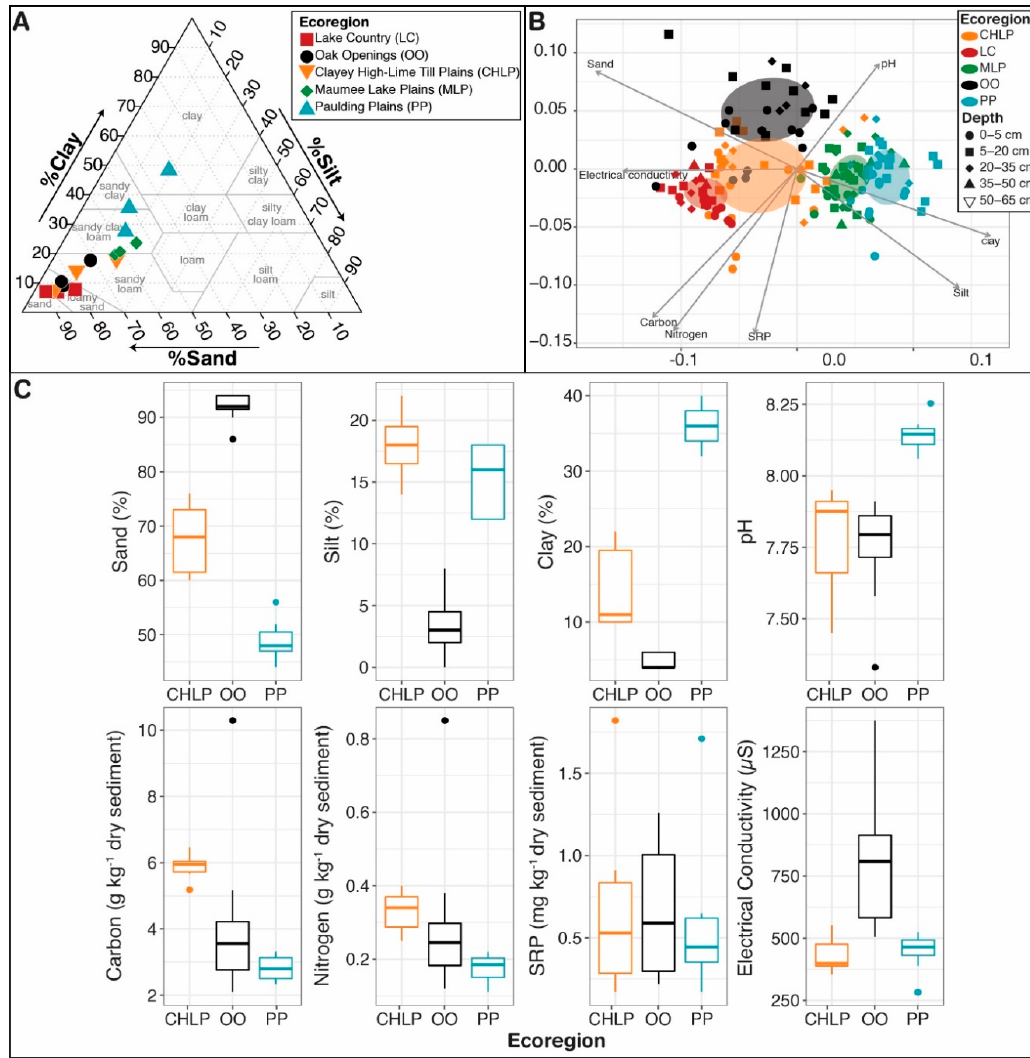
Figure A1. ( A ) Soil tests results for the three sites selected for further analysis for the top 20 cm (0–5 and 5–20 increments) from four bench positions. There are eight measurements made for each site with the boxes showing the 25th–50th–75th percentile (box), and whiskers showing the range of measurements. Outliers are shown as dots above or below the whiskers. ( B ) Nonmetric dimensional scaling (NMDS) analysis of the Spring 2014 data. Ecoregions (translucent circles) were significantly correlated to the ordination. The trends of the nutrients were plotted as arrows against this ordination. Each point represents the data from that sample and is colored by ecoregion and shaped by its depth. The plot was rotated to the principle coordinate axes (x = PC1). ( C ) Soil tests results for the three sites selected for further analysis for the top 20 cm from four bench positions ( n = 24). Boxes cover the 25th–75th percentile with lines indicating median, and whiskers showing the range of measurements using dots for outliers ( ± 1.5 ×